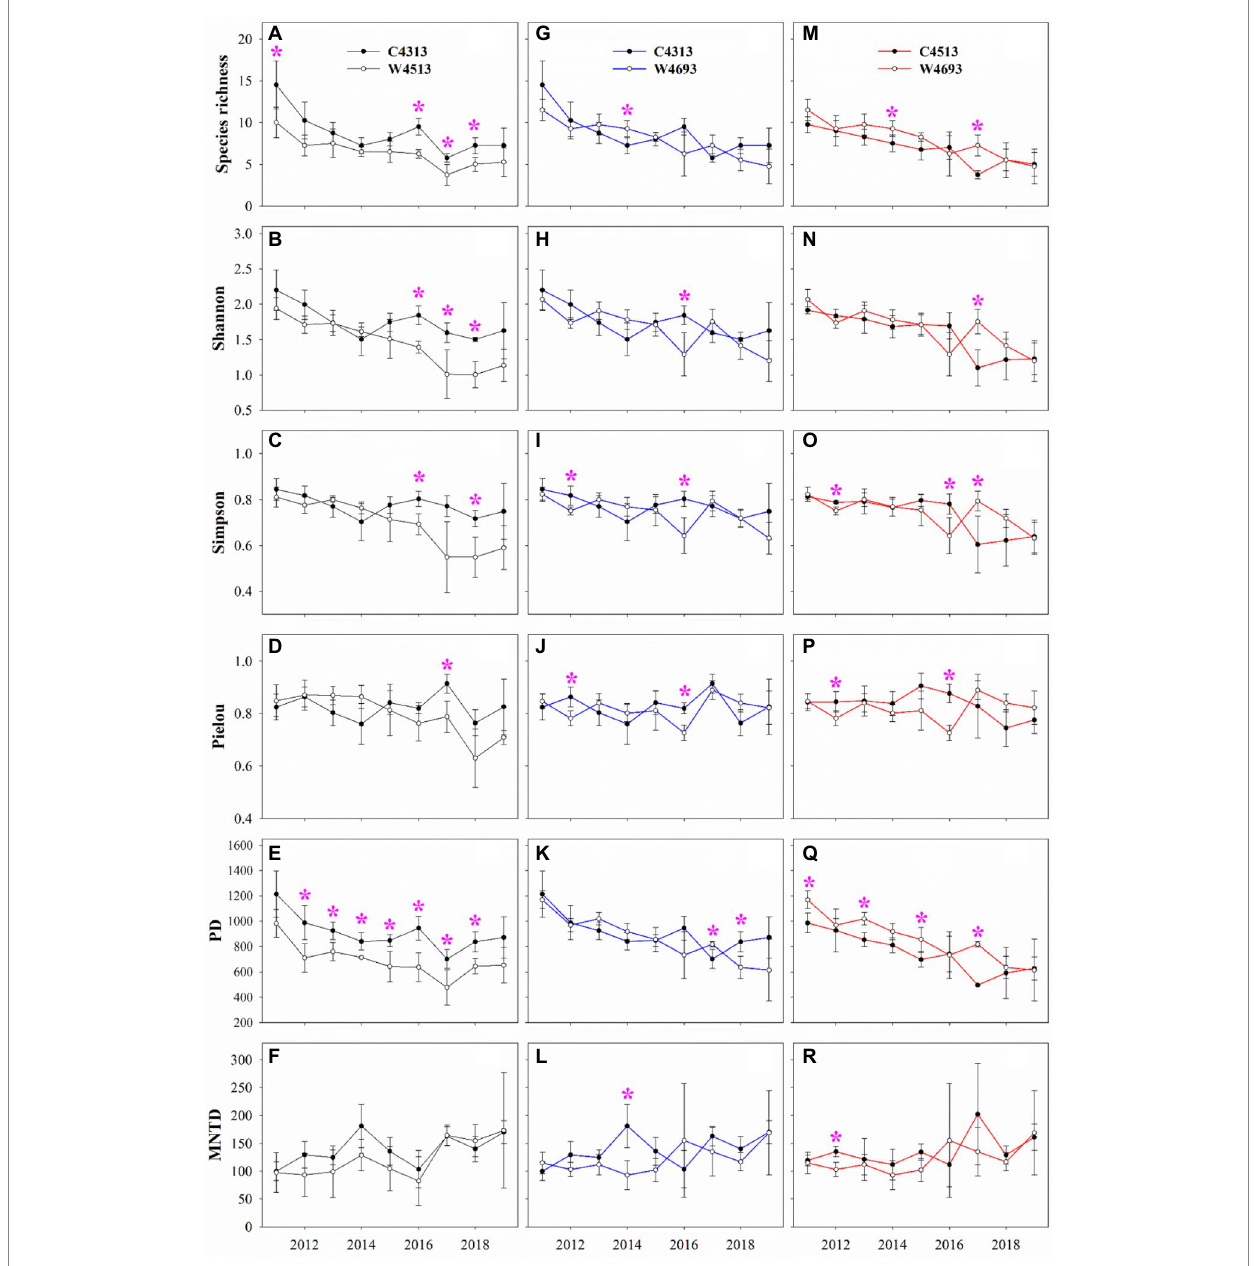
FIGURE 1 Comparison of species richness (SR), Shannon, Simpson, Pielou, Faith’s phylogenetic diversity (PD) and mean nearest taxon distance (MNTD) of plant community (A–F) between the non-warming plots at elevation 4,313 m (C4313) and warming plots at elevation 4,513 m (W4513), (G–L) between the C4313 and warming plots at elevation 4,693 m (W4693), and (M–R) between the non-warming plots at elevation 4,513 m (C4513) and the W4693.